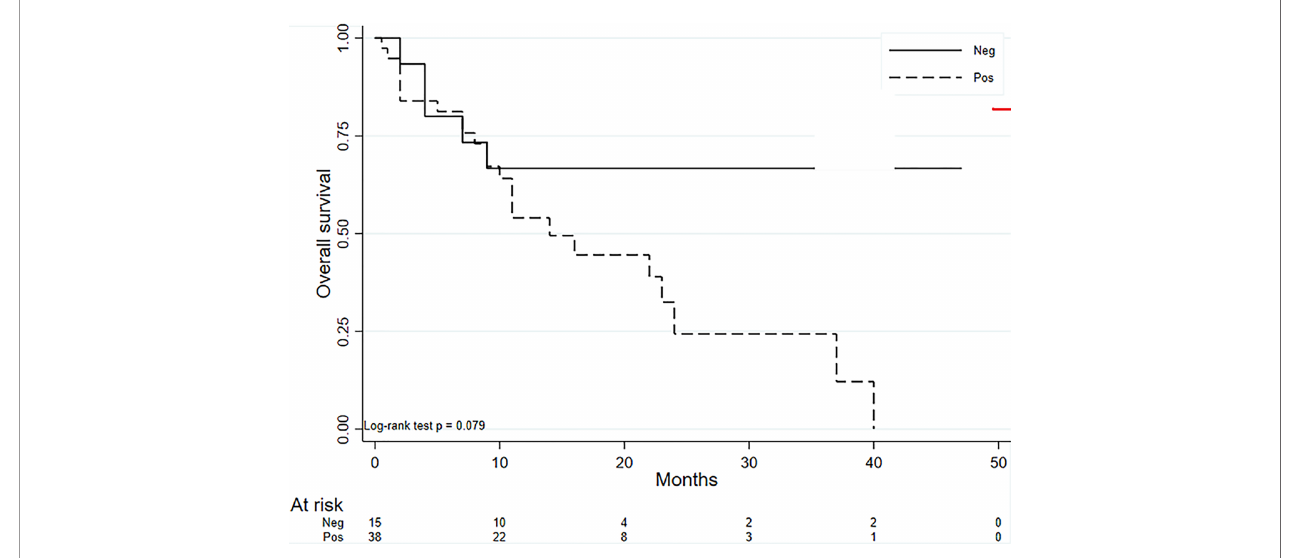
FIGURE 6 | Kaplan-Meier curves for OS for negative PD-L1 and vimentin expression (<1%) and positive PD-L1 or vimentin expression ( ≥ 1%).